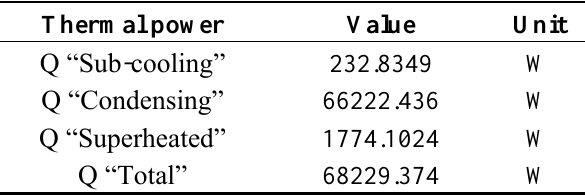
Table 8. Exchanged thermal power.